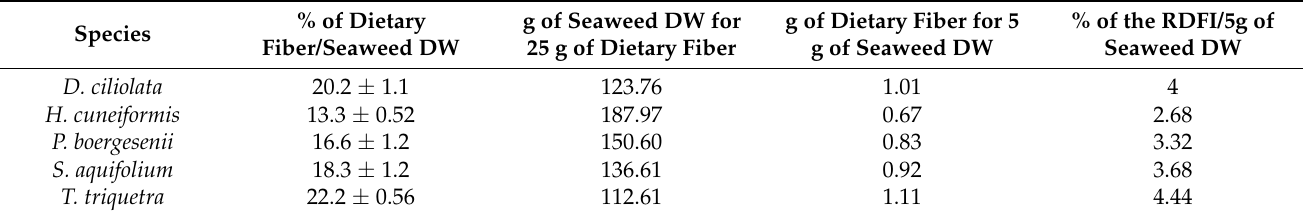
Table 6. Thresholds of daily consumption of seaweeds based on their polysaccharide content. % of Dietary g of Seaweed DW for Species Fiber/Seaweed DW 25 g of Dietary Fiber